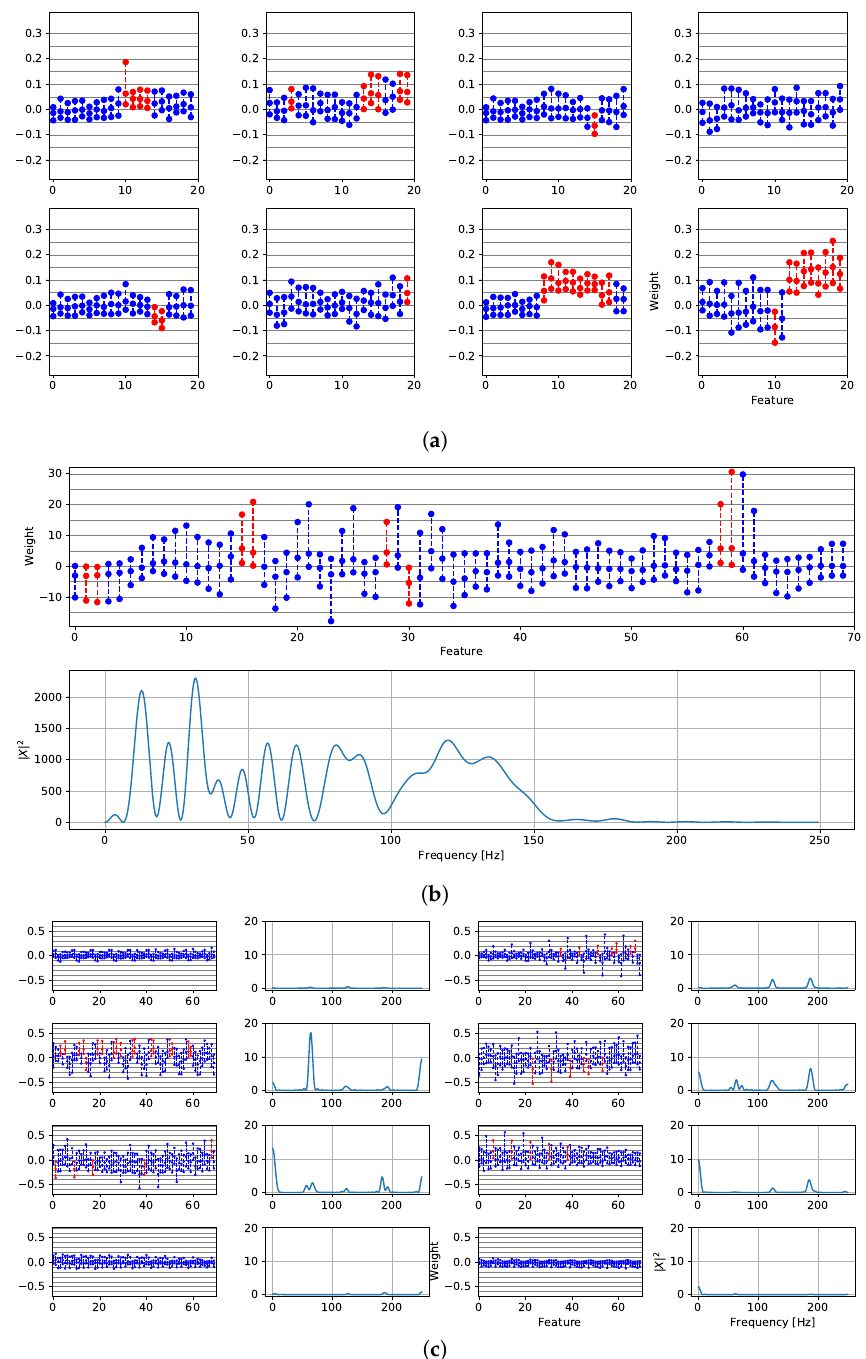
Figure 5. Statistical relevance of SVM coefficients. ( a ) Confidence interval at 95% of the ν -SVM weights for each statistic computed over the principal components of the normalized QRS for Sfrag-DB. Each panel shows the statistics for one principal component, the statistics were described in Section 3. ( b ) ν -SVM weights for FHCM-DB. Up: Confidence interval at 95% of the SVM weights for the power summation of regionalized principal components. Down: Fourier Transform of the coefficients, seen as a transversal filter. ( c ) ν -SVM weights for FHCM-DB, computed from the concatenation of non-normalized QRS extracted from eight independent leads. The first and third columns show the confidence interval at 95% of the SVM weight for each independent lead, the second and fourth columns show the impulse response created by using the weights as coefficient of filter. Red lines correspond to weights the confidence interval of which does not overlap the